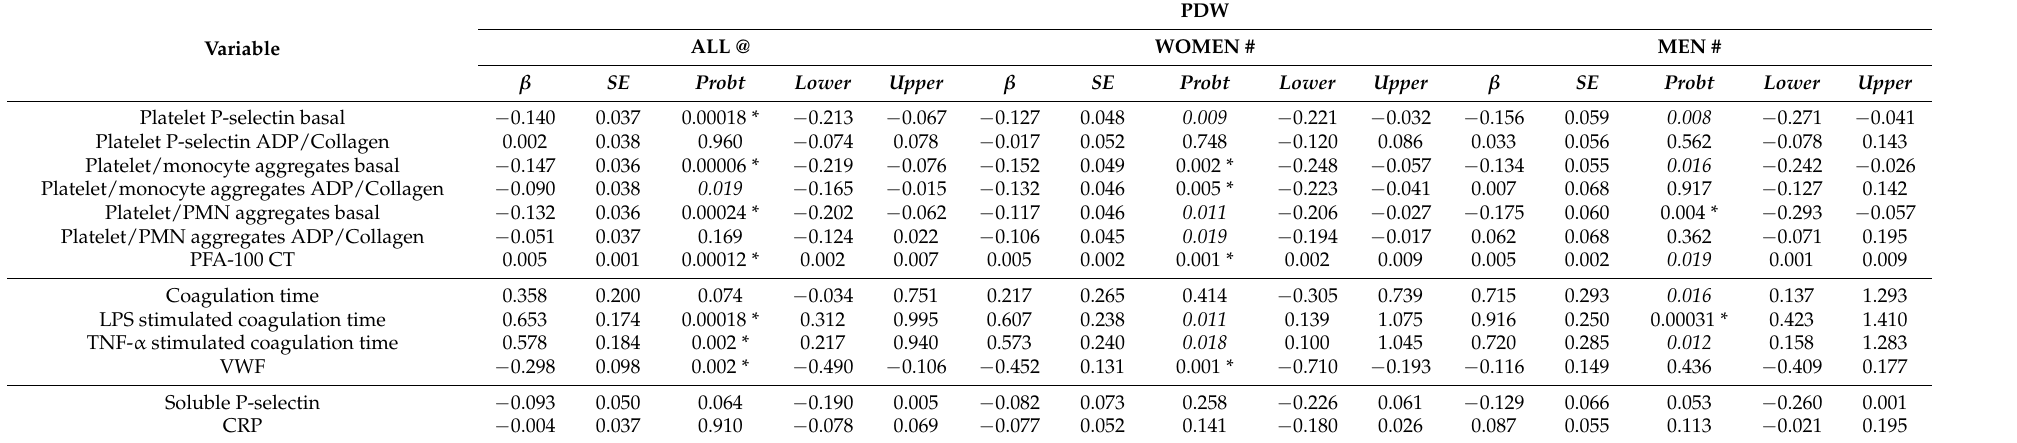
Table 2. PDW association with thrombo-inflammatory and coagulation